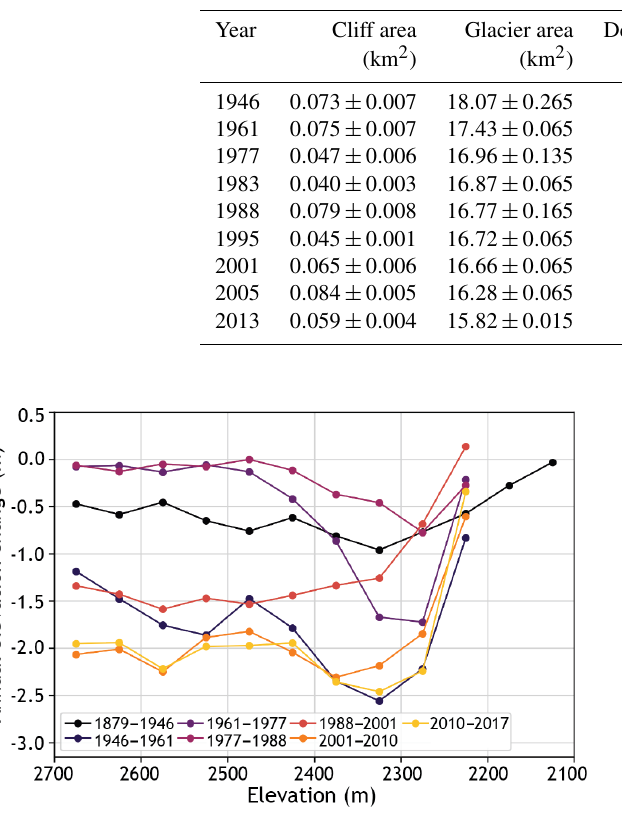
Figure 11. Average annual elevation change as a function of surface elevation (in 50m elevation bins) for seven time periods since